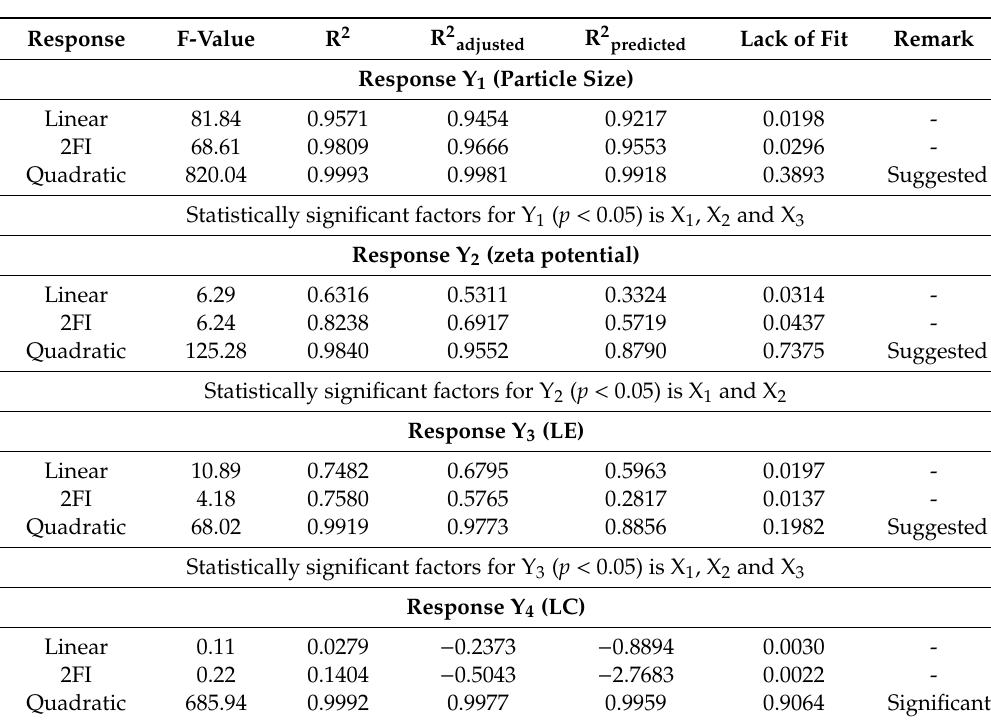
Table 5. Summary results of regression analysis for